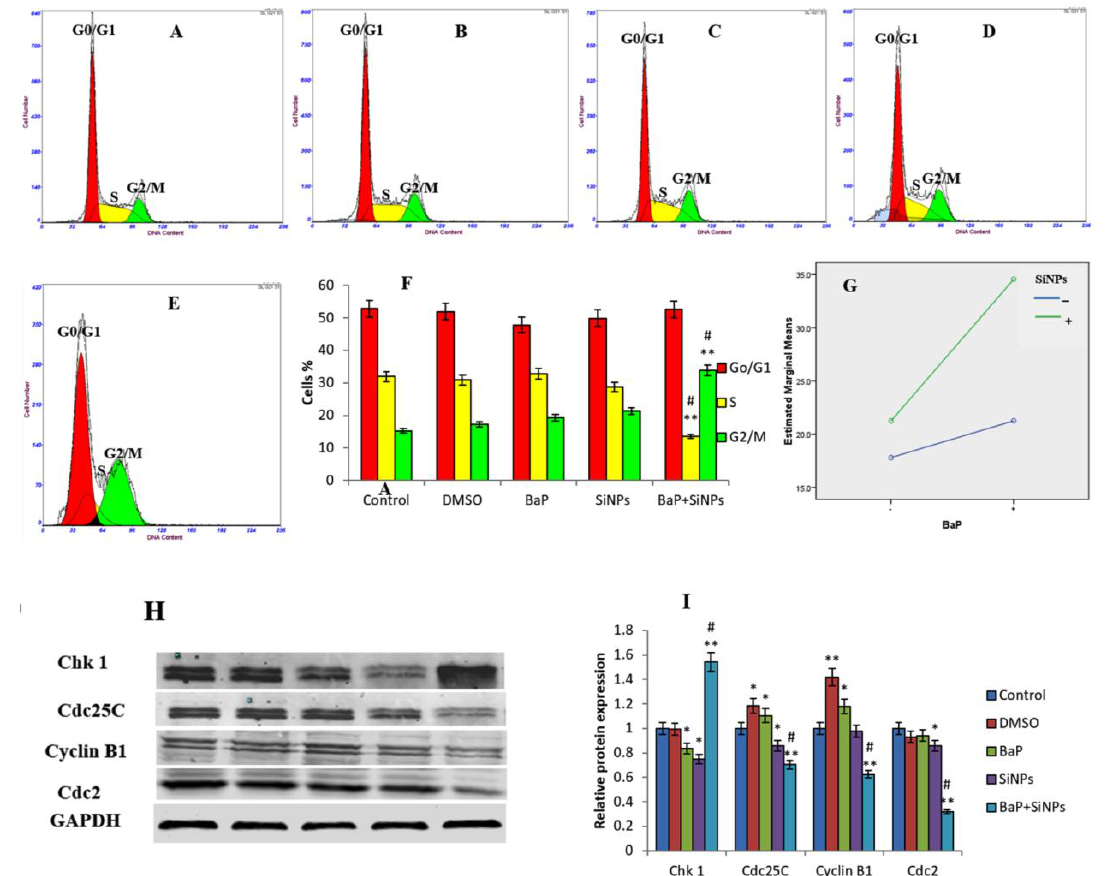
Figure 7. Cell cycle phase distribution in various treatment groups. ( A ) Control; ( B ) DMSO (0.1%); ( C ) B[a]P (1 µ M); ( D ) SiNPs (10 µ g/mL); ( E ) B[a]P + SiNPs (1 µ M + 10 µ g/mL) treatment; ( F ) Percentages are mean ± SD of each cell cycle phase for triplicate experiments; ( G ) Factorial analysis plots show a synergy interaction between SiNPs and B[a]P ( F = 27.637, p = 0.001). ** p < 0.01 for the treated group compared to the control, while # p < 0.05 for the combined group compared to single treated groups; ( H ) Western blot results show a significant increase in Chk1 expression and decrease in Cdc25C, Cyclin B1, and Cdc2 expression; ( I ) the graph shows a significant change in the protein expression of the co-exposed group compared to the other groups.